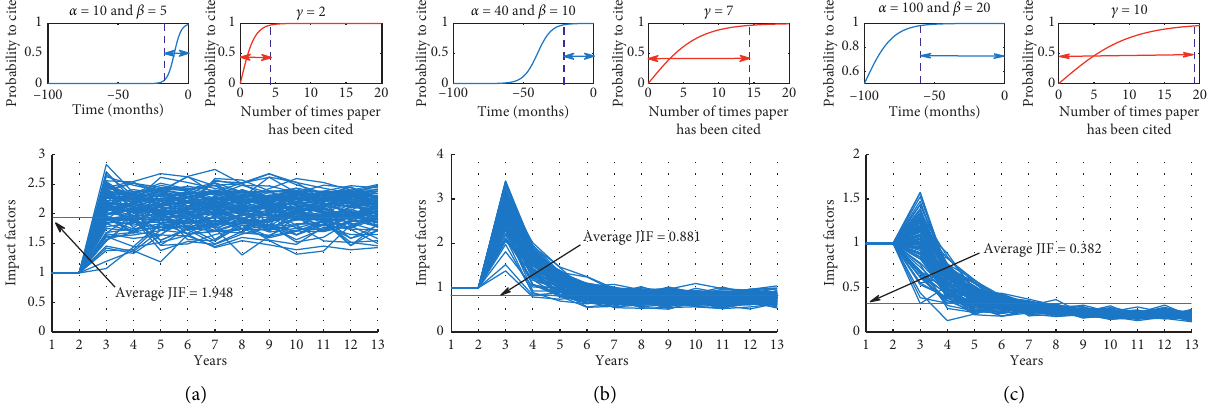
� 20 and N � 5. ( max ) ( min )